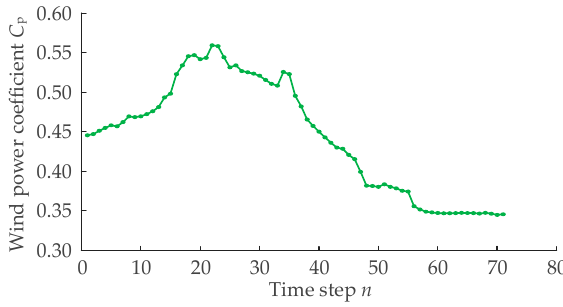
ffi cient trends with time (total time step n = Figure 6. Wind power coefficient trends with time (total time step n = 73). Figure 6. Wind power coe Figure 6. Wind power coefficient trends with time (total time step n = 73).